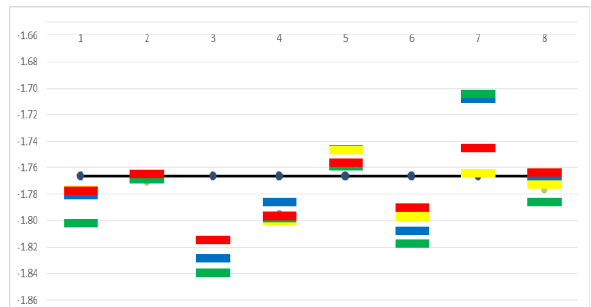
Figure 14. Ceiling of second level.